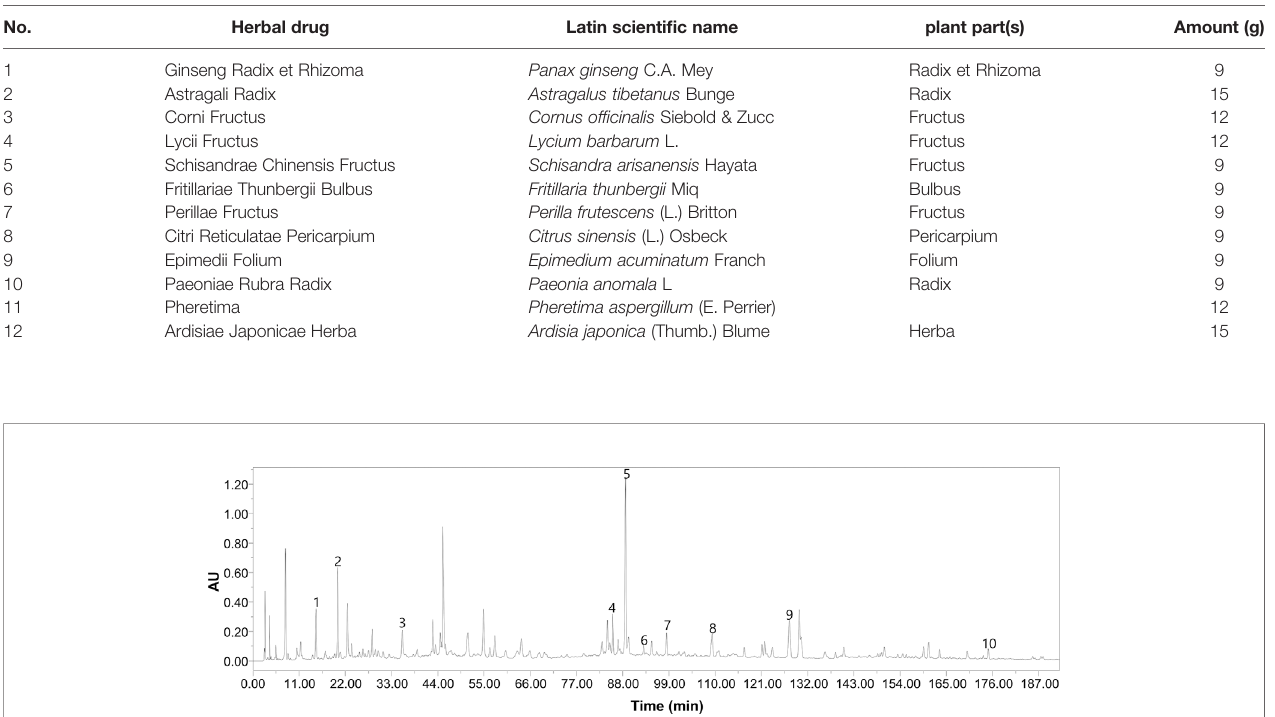
TABLE 1 | The compositions of Bufei Yishen formula.